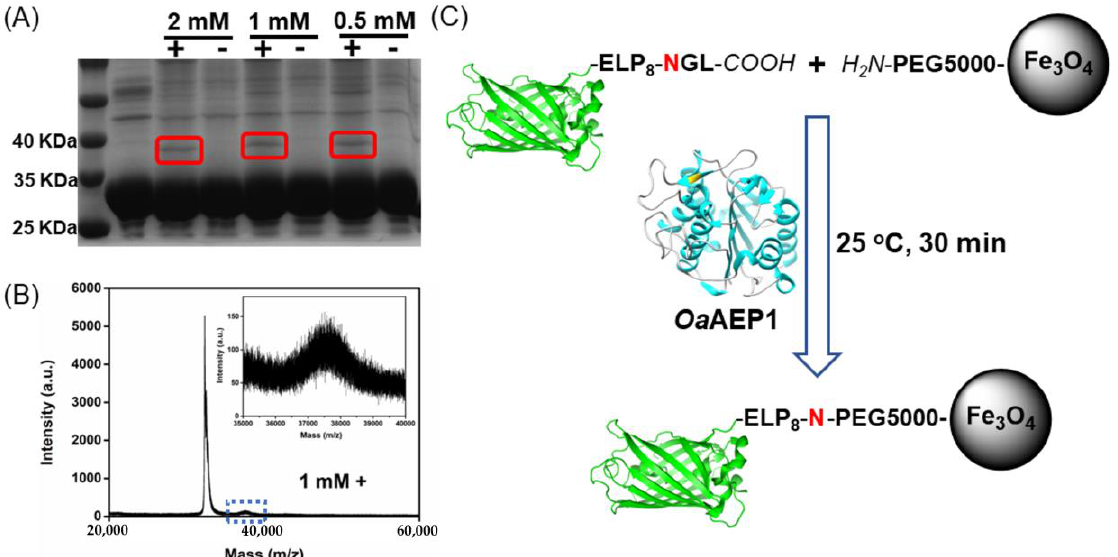
Figure 2. ( A ) SDS-PAGE gel result of the ligation of eGFP – ELP 8 – NGL with PEG5000 – NH 2 (2 mM; 1 mM; 0.5 mM) when Oa AEP1 was present and absent. ( B ) MALDI-TOF MS result of the ligation of